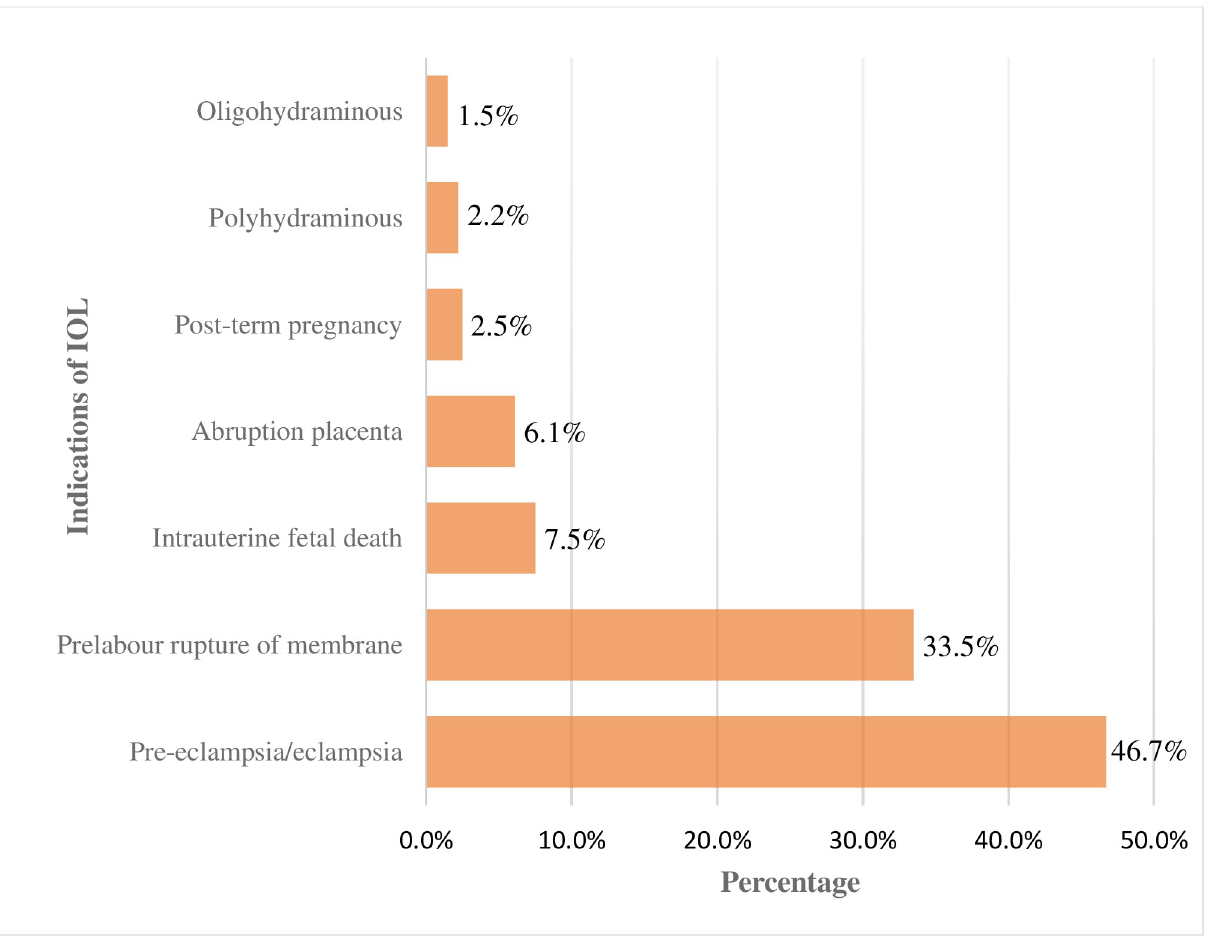
Fig 3. Indications for induction of labor among mothers who delivered after induction of labor in public Hospitals in Harari Regional, Eastern Ethiopia, 2019.